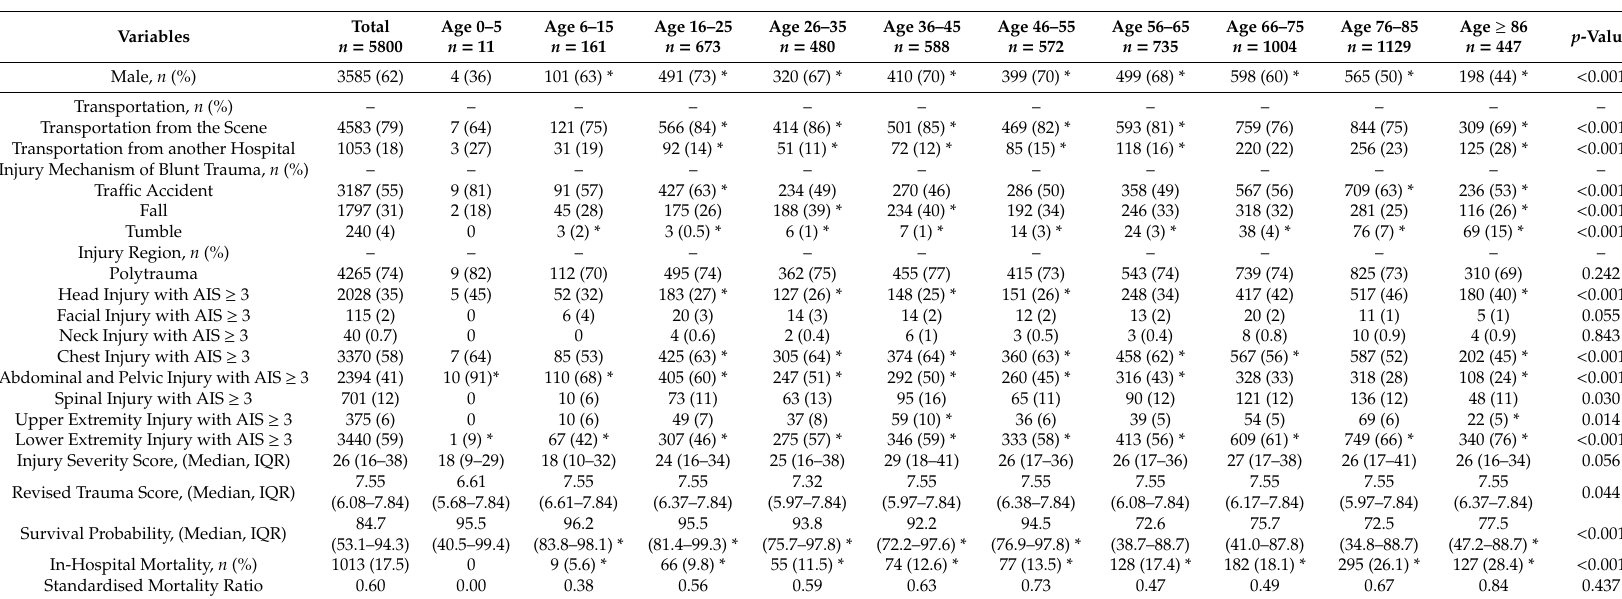
Table 1. Demographics and outcomes of trauma patients who underwent transcatheter arterial embolization and di ff erences between the age-stratified